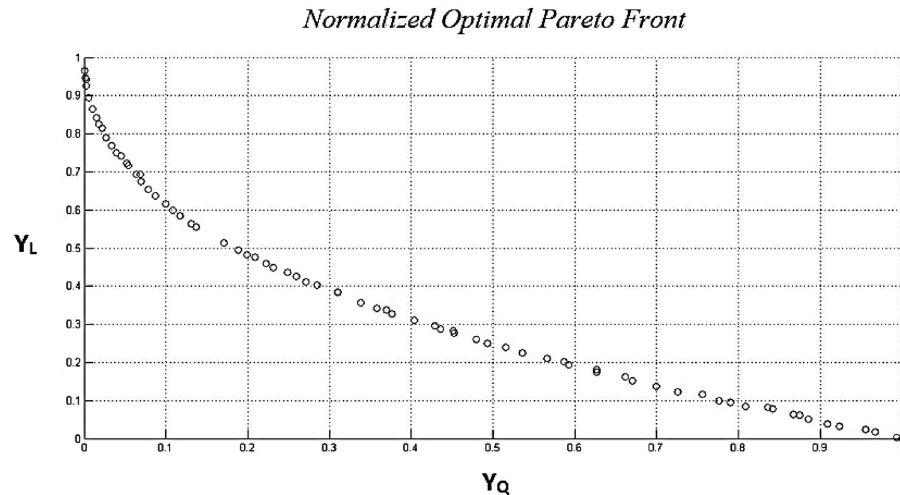
Fig. 16 Normalized optimal Pareto front of the case study